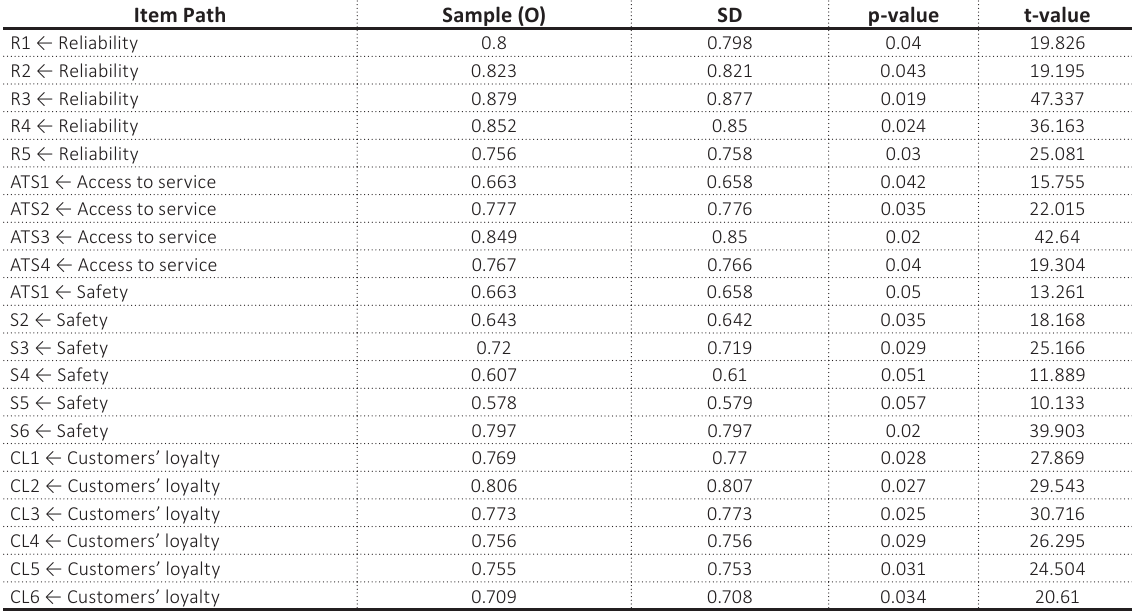
Table 6. Item-wise impact on